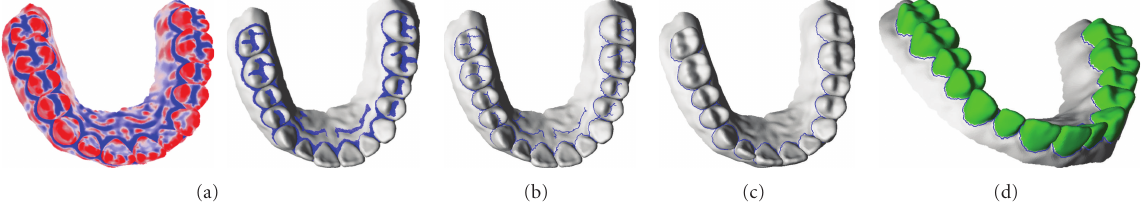
Figure 14: Procedure of segmentation boundary extraction and single-tooth separation. (a) 3D dental model with extracted feature regions. (b) after peeling. (c) after pruning. (d) single-tooth separation.